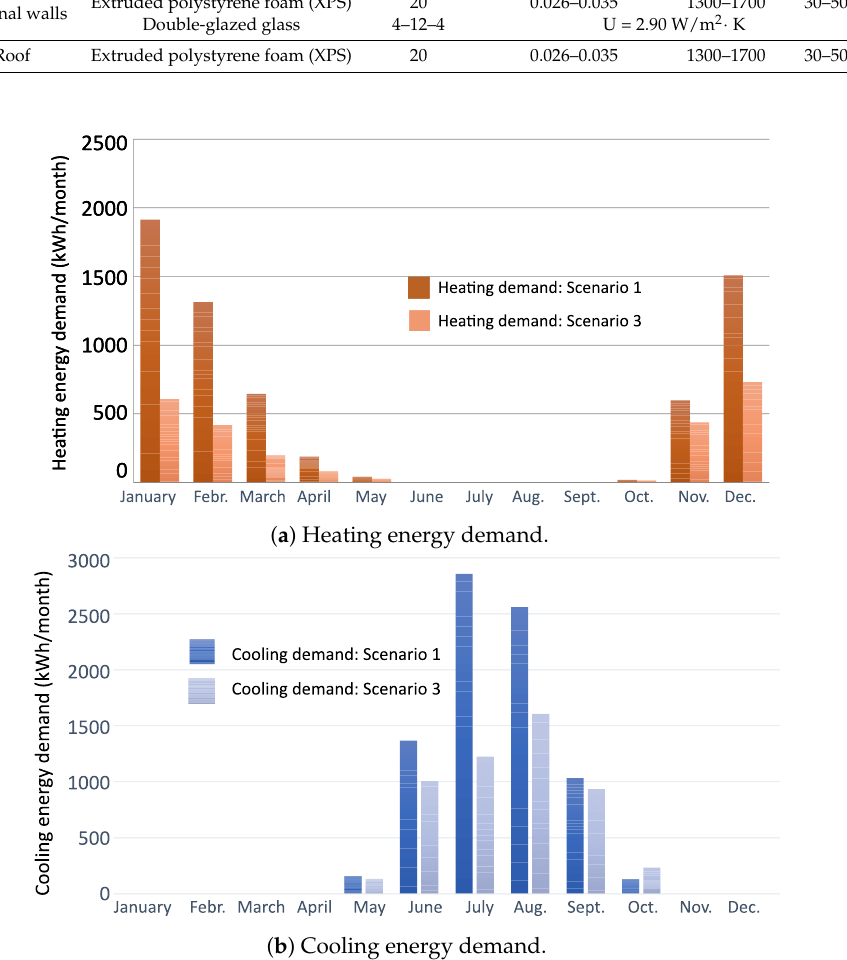
Figure 11. Heating/cooling energy demand. Reference residential building—Scenario